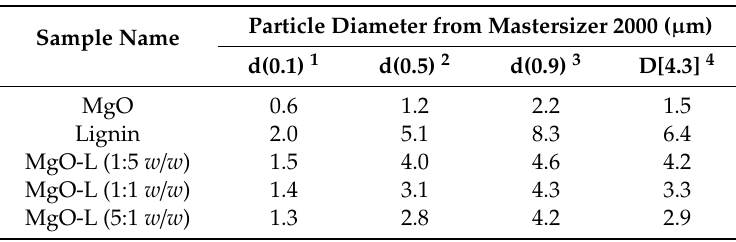
Table 2. Particle diameter of MgO, biopolymer and MgO-lignin hybrids from Mastersizer 2000.